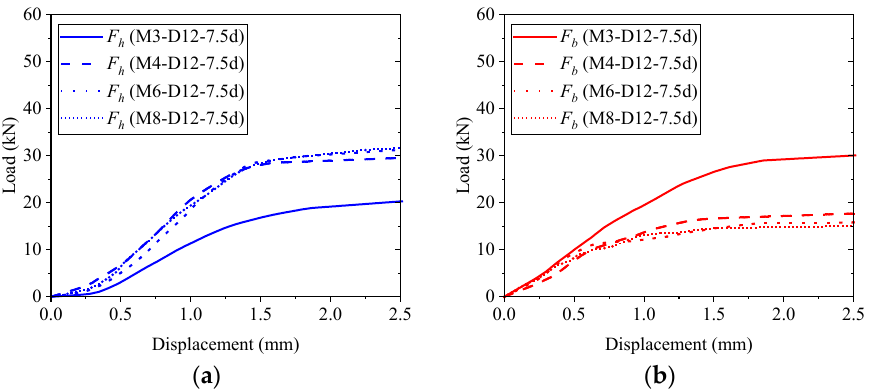
Figure 23. Comparison of head bearing and bond among specimens with different head size ( a ) Head bearing; ( b ) Bond behavior.